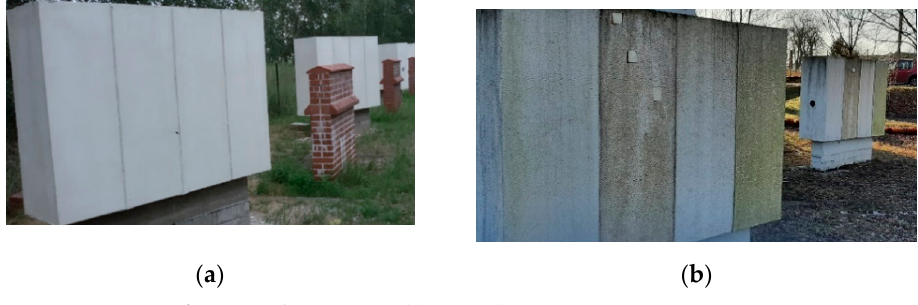
Figure 6. Test site for natural aging test: ( a ) 2016; ( b ) 2022.